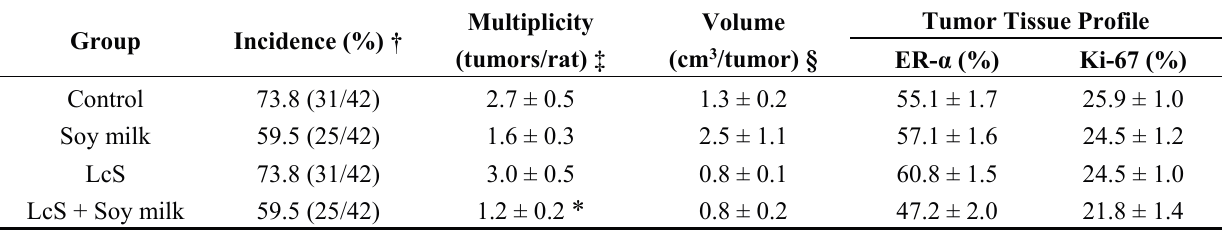
Table 2. Incidence, multiplicity, volume and immunohistological profiles of mammary tumors in PhIP (2-amino-1-methyl-6-penylimidazo[4,5-b]pyridine)-exposed rats [47]. Group Incidence (%) †